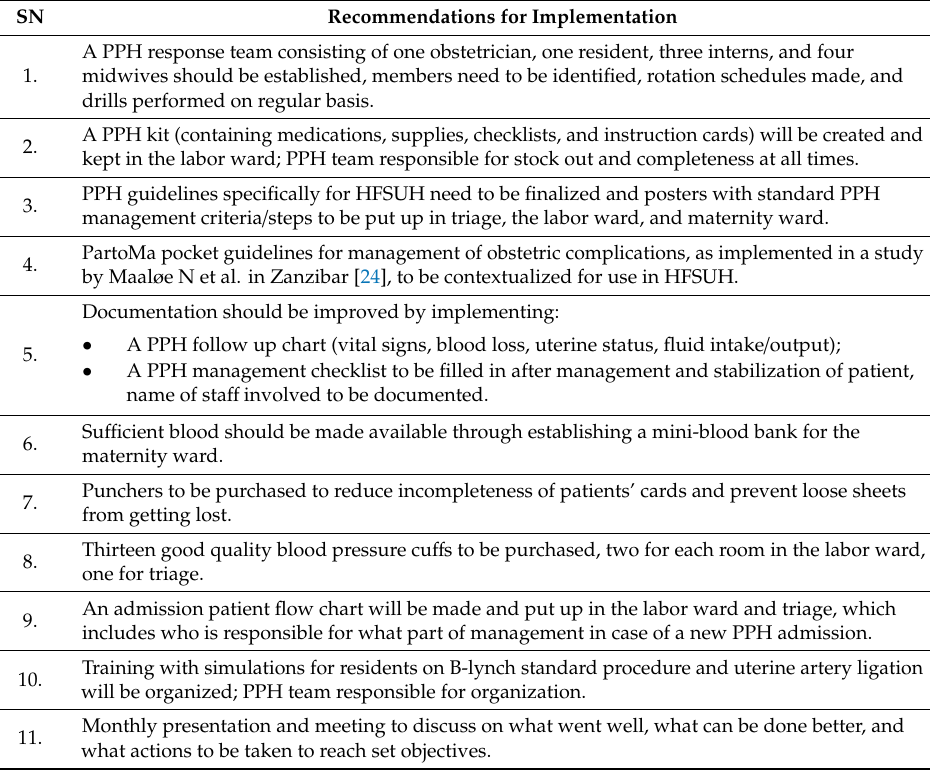
Table 4. Recommendations for improving PPH management in HFSUH, 2019. Recommendations for